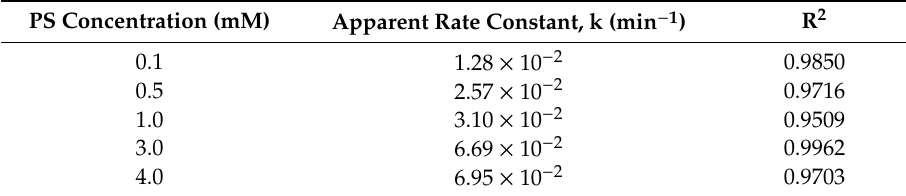
Table 3. The kinetic parameters of NOR degradation at di ff erent PS concentrations.